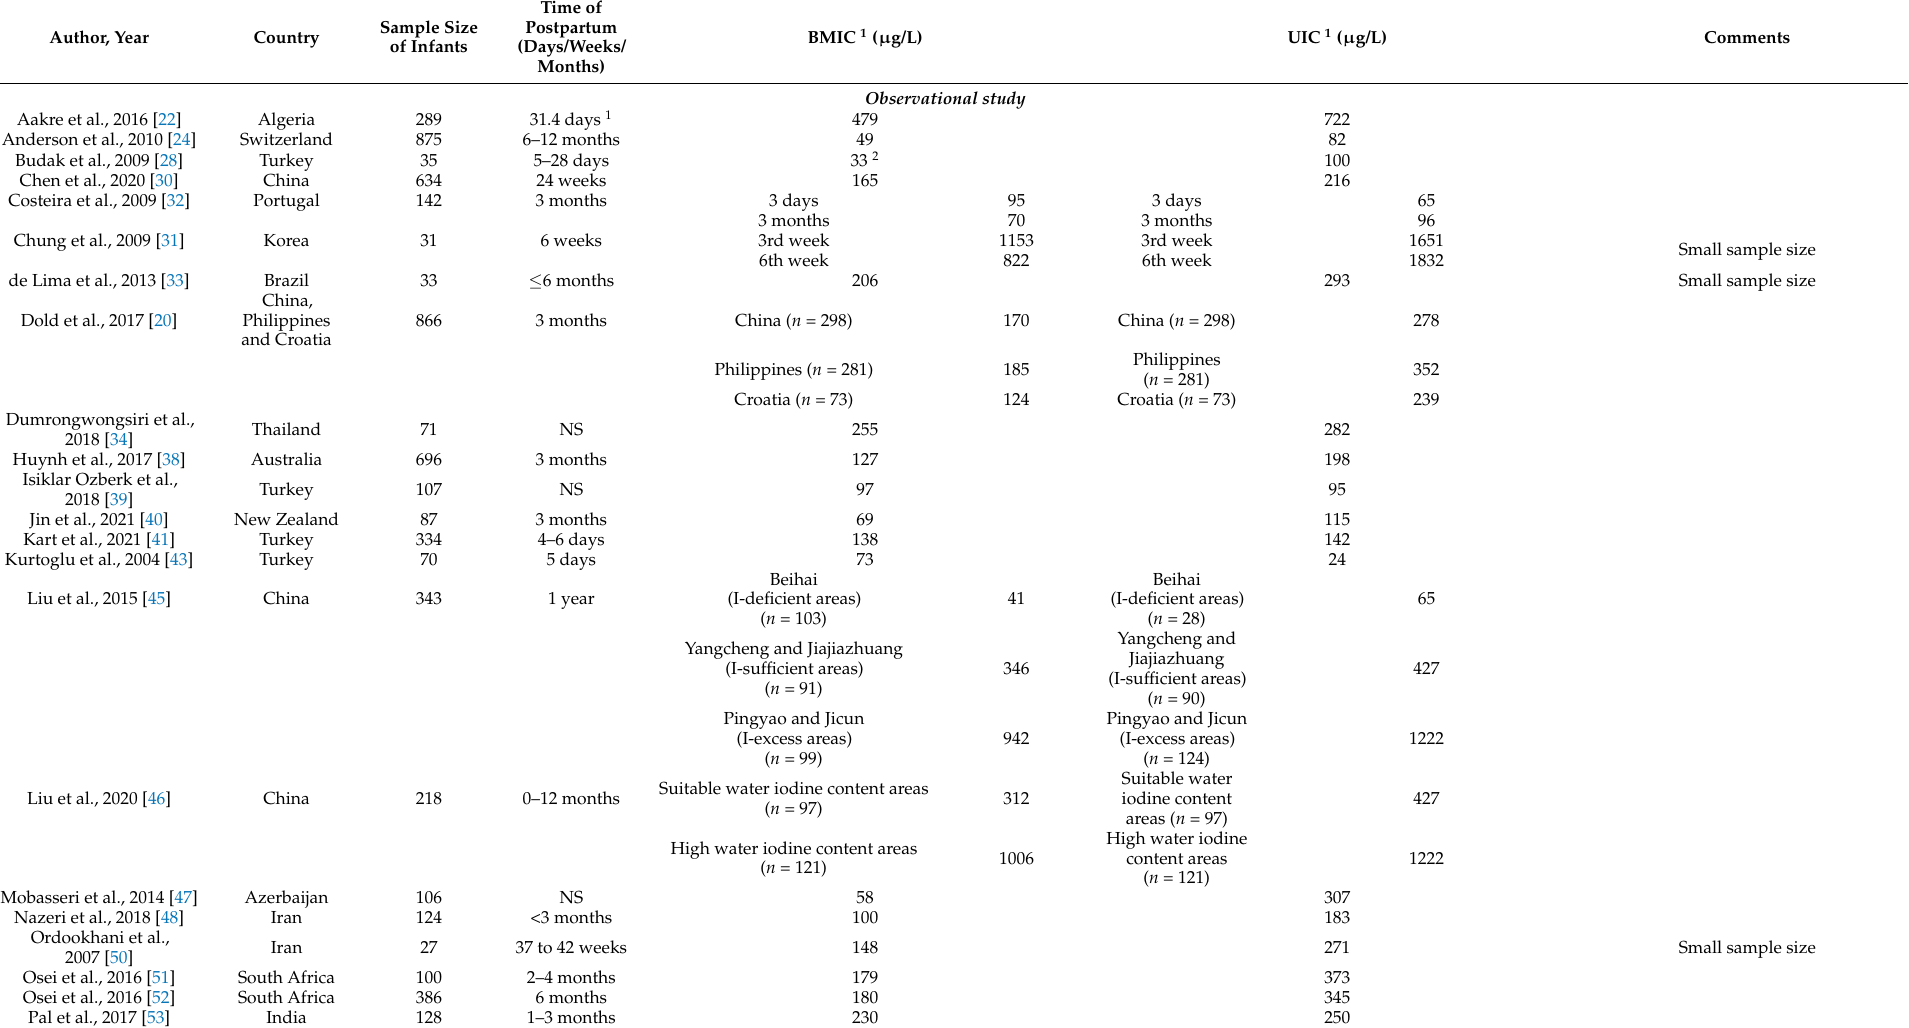
Table 4. BMIC of lactating women and UIC of